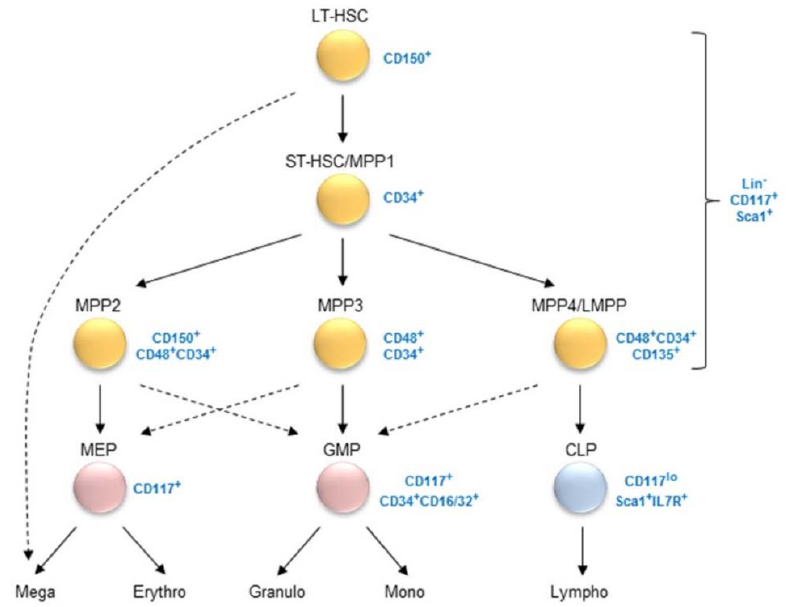
Figure 1. Murine early hematopoiesis from long-term hematopoietic stem cells towards the different lineages. Plain and dashed arrows show the main and the alternative branch points, respectively. Hematopoietic progenitors do not express markers of the different hematopoietic lineages and are therefore said to be lineage-negative (Lin − ). Markers used to characterize the different hematopoietic progenitors are indicated. LT-HSC: long-term hematopoietic stem cell (HSC); ST-HSC: short-term HSC; MPP: multipotent progenitor; LMPP: lymphoid-biased multipotent progenitor; MEP: megakaryocyte-erythroid progenitor; GMP: granulocyte-monocyte progenitor; CLP: common lymphoid progenitor; Mega: megakaryocyte; Erythro: erythrocyte; Granulo: granulocyte; Mono: monocyte; Lympho: lymphocyte; Lin: lineage markers.